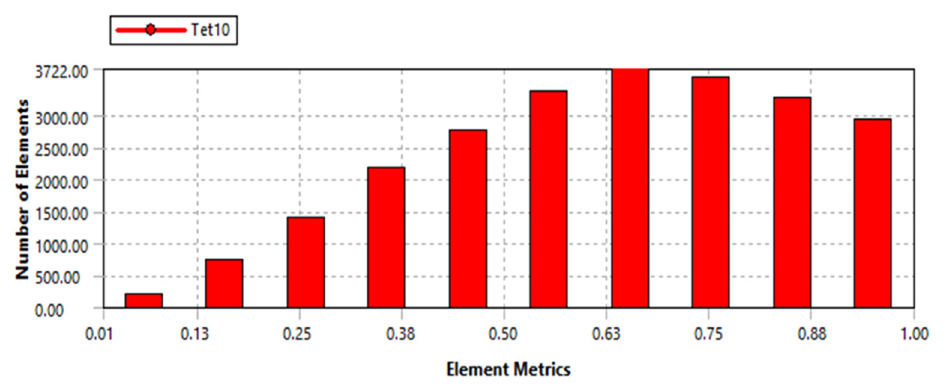
Figure 7. Meshing model of micropositioner: Meshed quality criteria using skewness. Table 2. Numerical results (Input displacement of 77 µm).